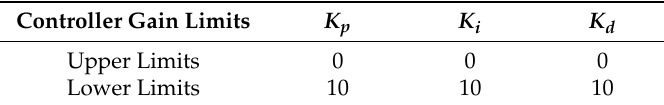
Table 1. Limits of Controller Parameters.